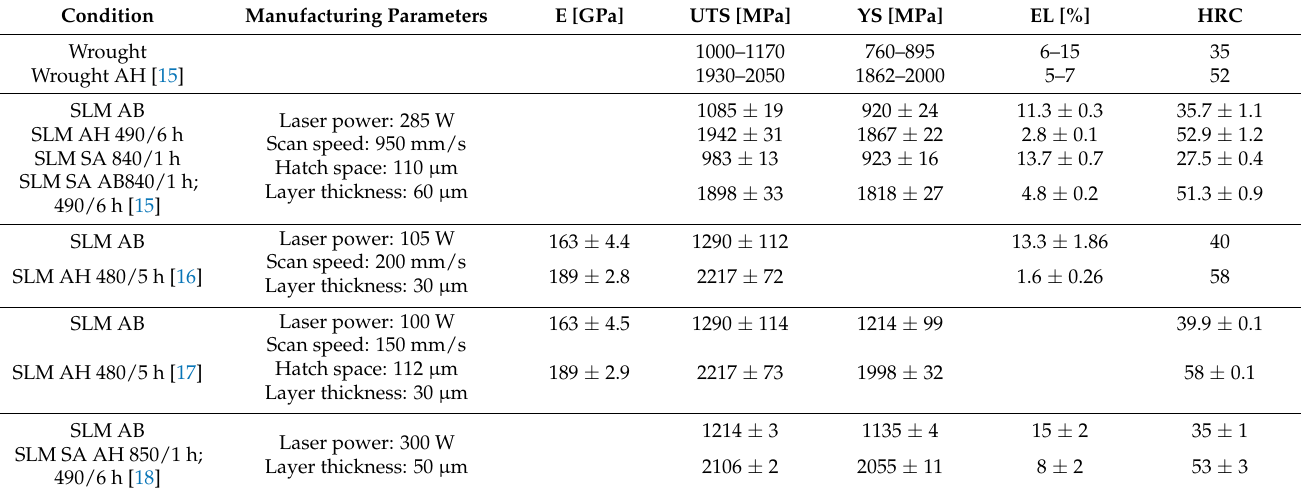
Table 1. Overview of published mechanical properties of M300 maraging steel. AB: as built, SA: solution annealed, AH: aging heat